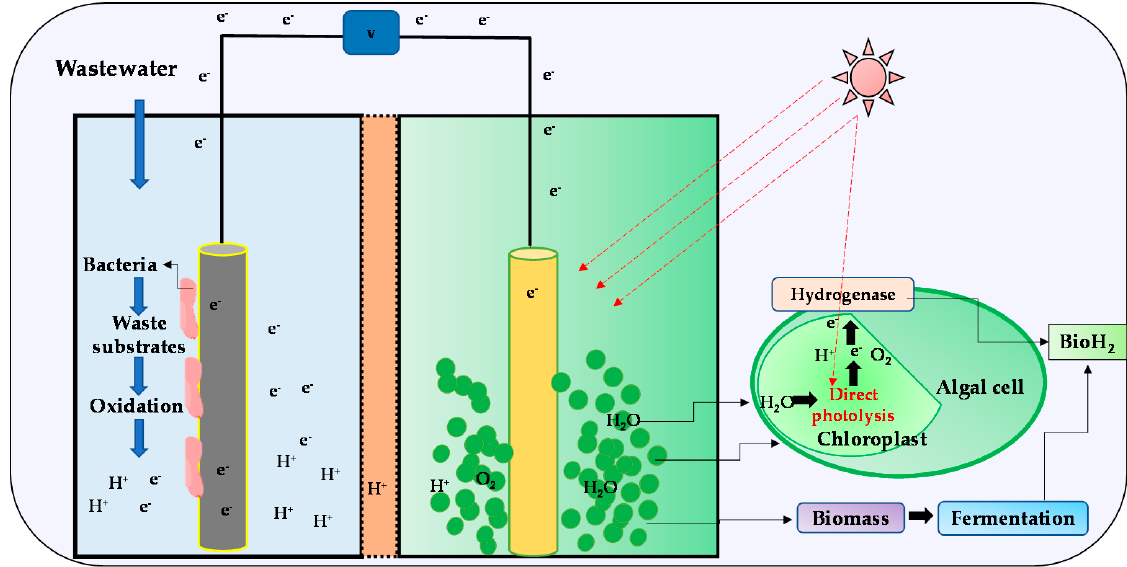
Figure 6. Microalgal based microbial fuel cells (MB-MFCs)-based wastewater treatment and bioH 2 production. Reproduced from [2,147], Elsevier B.V.: 2020. Table 8. Fuel properties and comparison of different biochar derived from microalgal bio-mass and other biomass. Table 7. Different microalgae used for bioelectricity generation. t & Type of Biomass